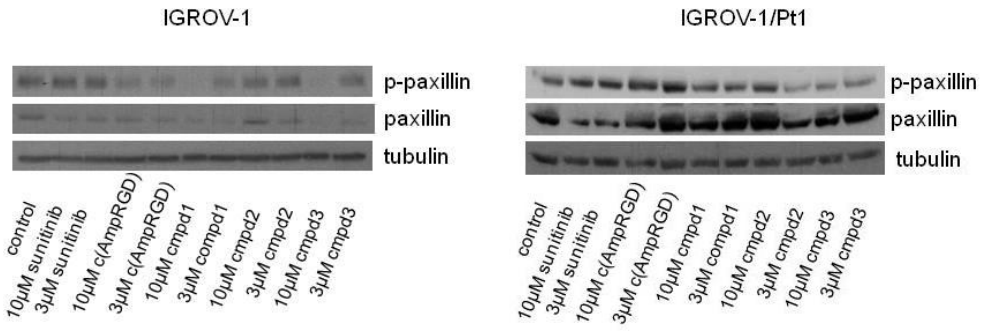
Figure 5. Western blot analysis of paxillin and phosphorylated-paxillin (p-paxillin) levels in IGROV- 1 and IGROV- 1/Pt1 cells. Cells were exposed for 24 h to sunitinib or to selective binders of α V β 3 integrin linked to sunitinib (compounds 1 – 3 ) at the indicated concentrations and then harvested for western blot analysis. Tubulin was used as loading control. A representative experiment is shown (for quantification of band intensities, see Table S2). For whole Western blot analysis of paxillin and phospho-paxillin levels in IGROV-1 and IGROV-1/Pt1 cells, see Figure S4.